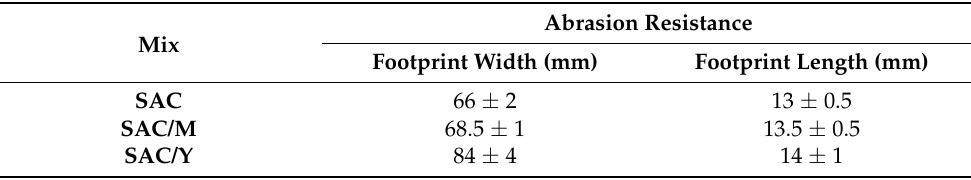
Table 7. Abrasion resistance (mean value and standard